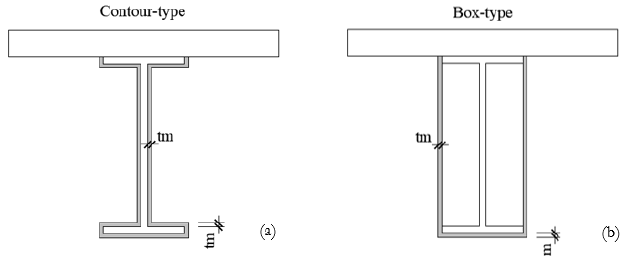
Figure 4. Fire protection coating: (a) contour-type and (b)